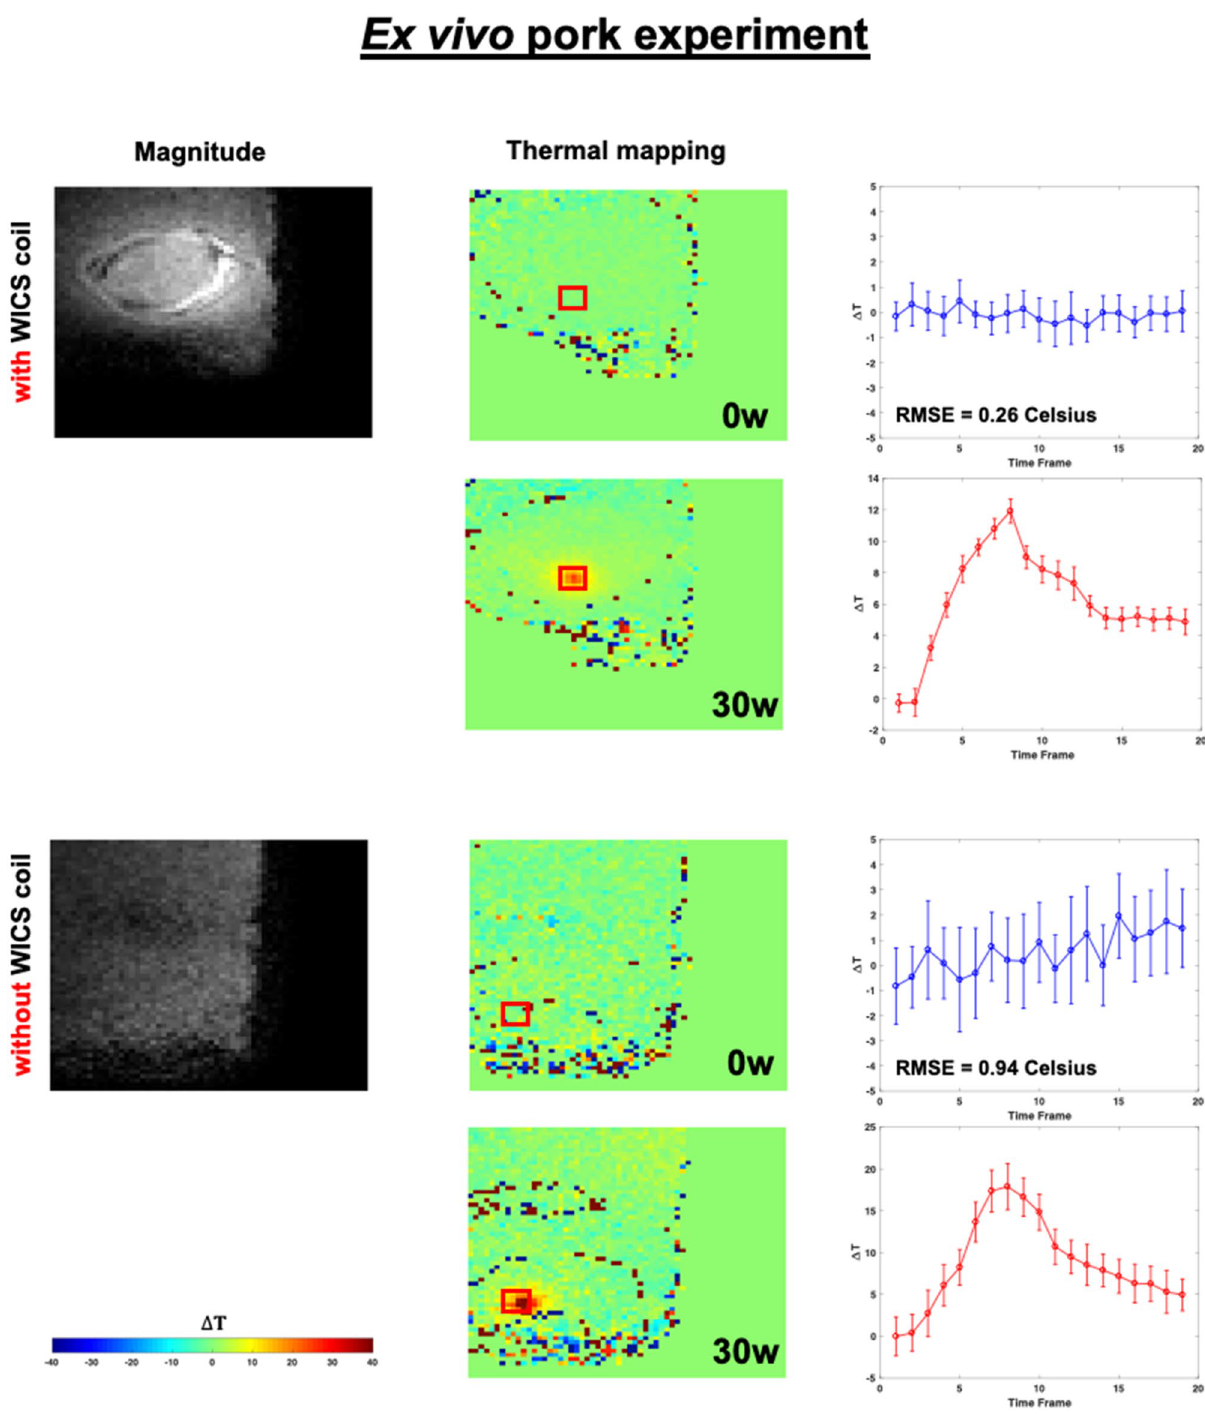
Figure 9. The magnitude image and the corresponding temperature map marked with the location of the ROI in the HIFU ex vivo pork experiment, with (upper) and without WICS coil (lower) for both without and with